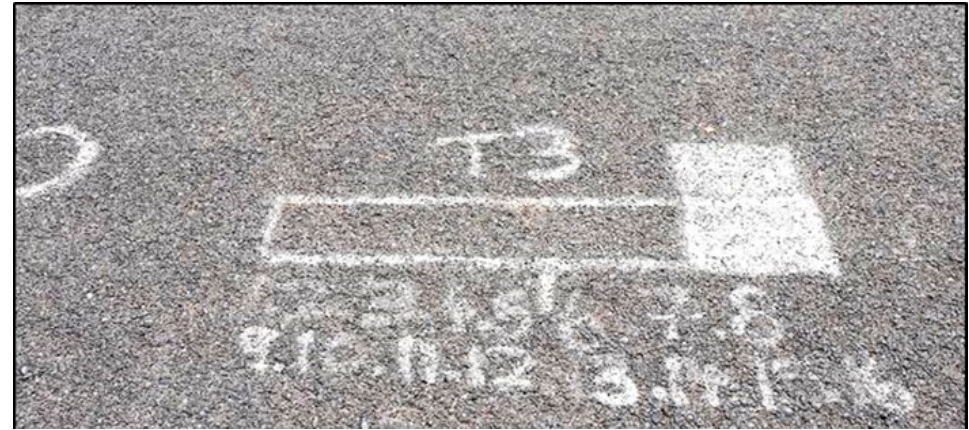
Figure 10. Condition of the 20/7 double seal after APT at <20 °C.